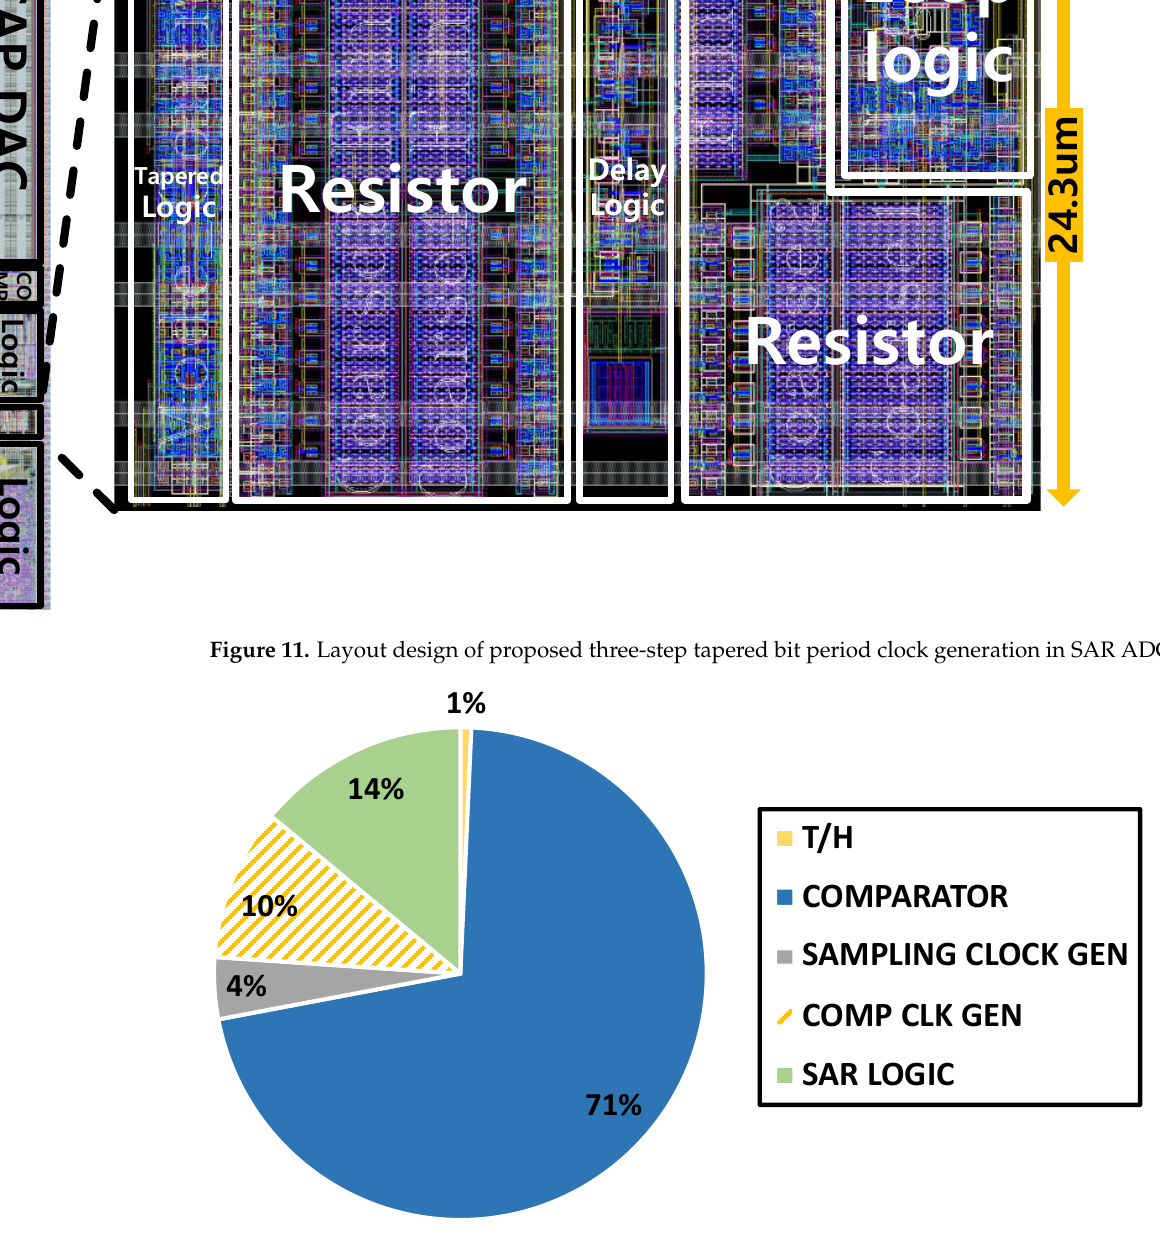
Figure 12. Power breakdown of